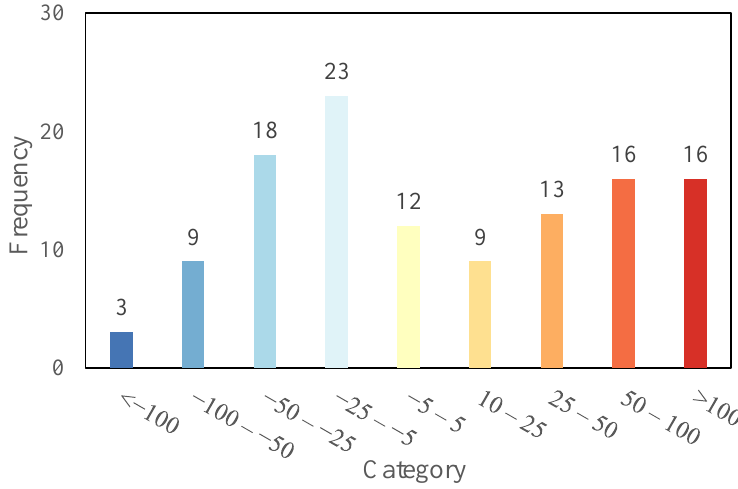
Figure 3. Frequency of each imbalance intensity category.